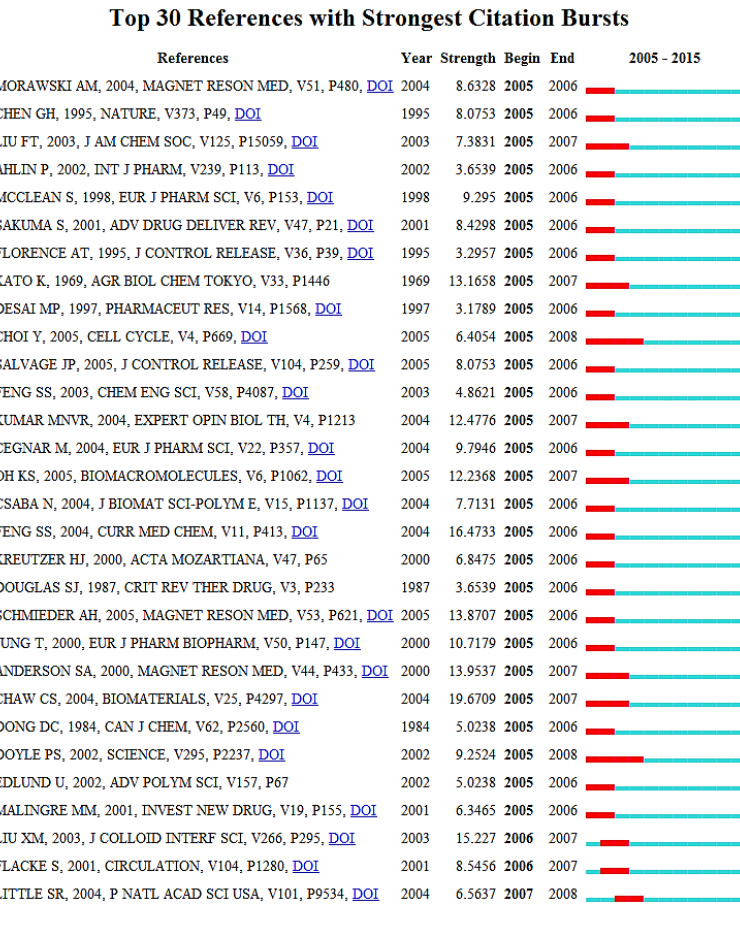
Figure 4. Top 30 references with strong citation bursts.